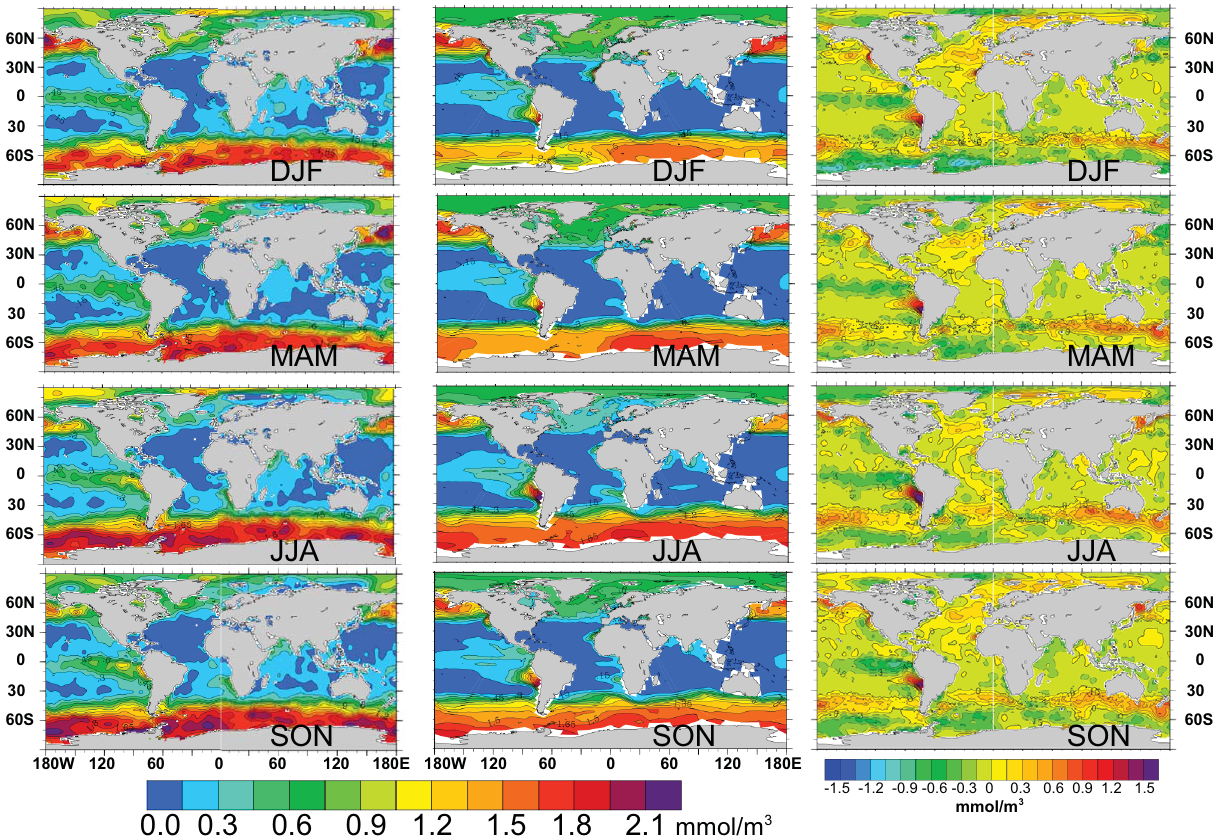
Fig. 3. Seasonal cycle of surface phosphate from observations from the World Ocean Atlas (left, Garcia et al., 2010), compared to model results (average for years 1993–2008, middle column), and modelled minus observed surface phosphate (right). Table 1. Model experiments. CWE is climate warming effect, CEE is carbon emission effect, AES is anthropogenic eutrophication scenario.